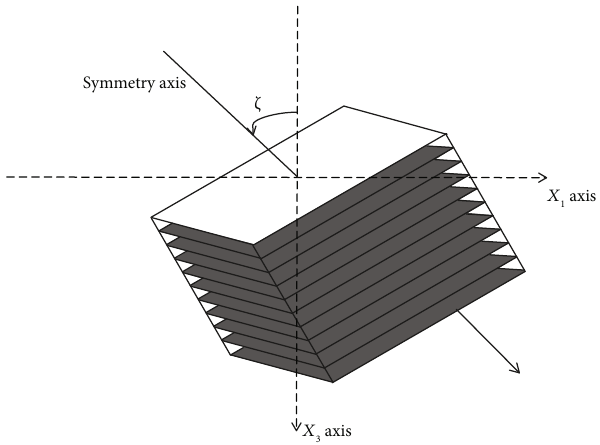
Figure 1: A TTI medium with dip angle ζ of symmetry